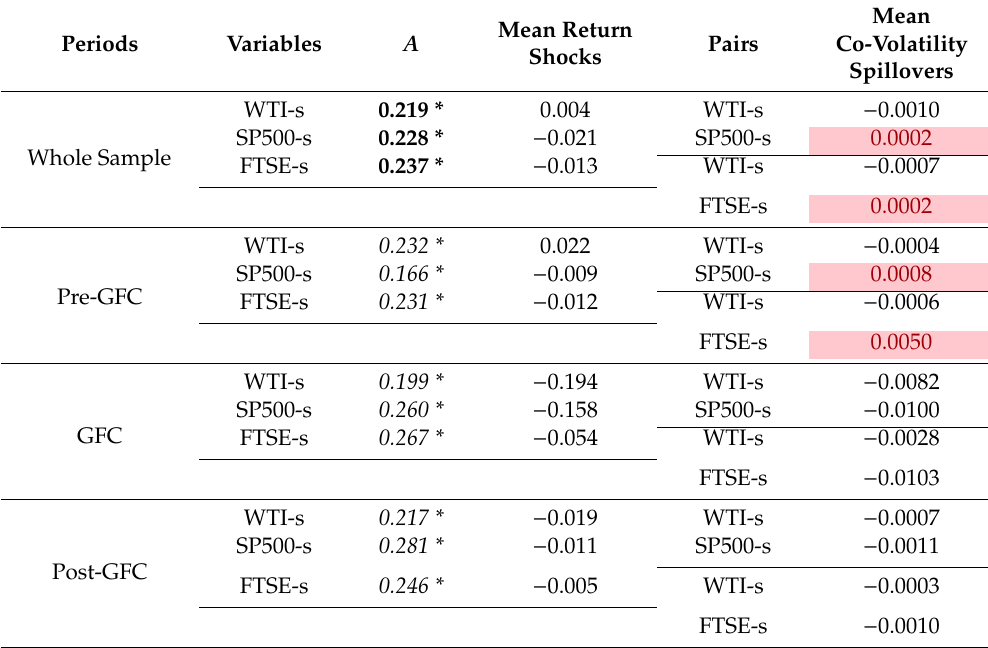
Table 7. Matrix A in Diagonal BEKK, mean return shocks, and mean co-volatility spillovers for the UK and US spot markets, four periods (3 ×